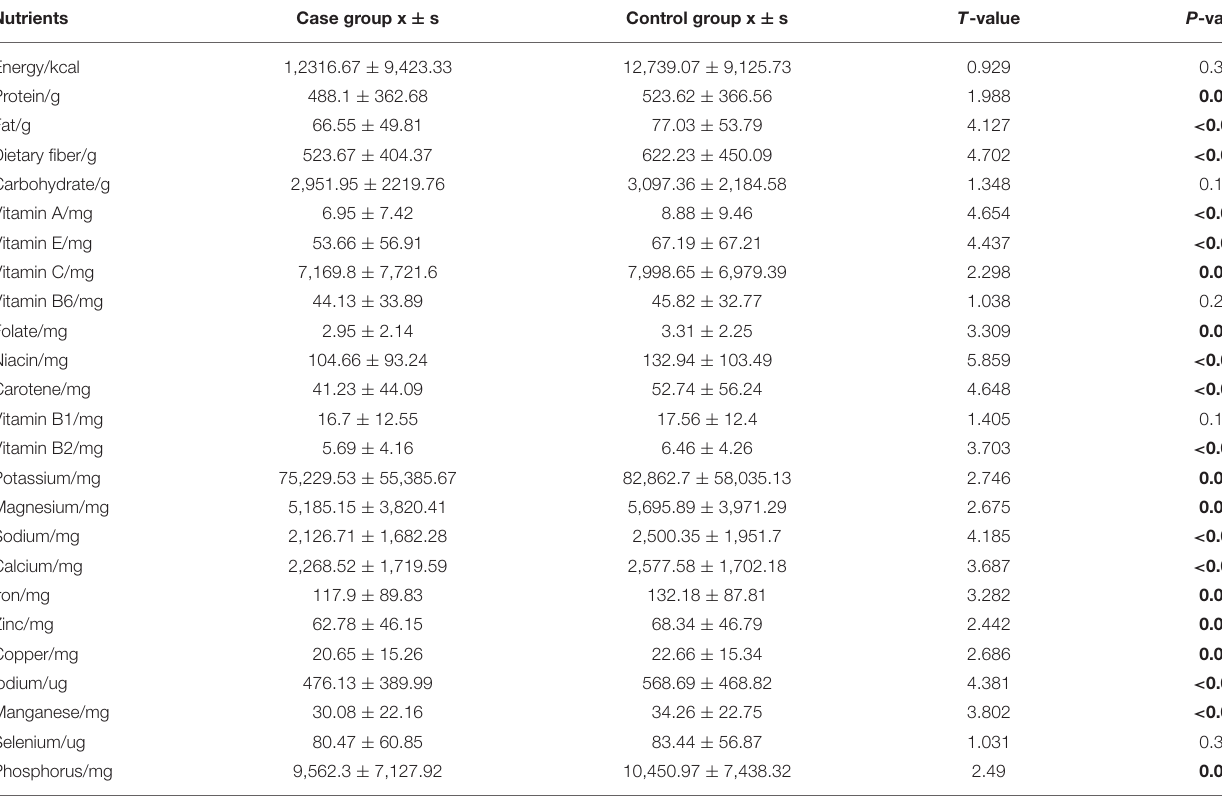
TABLE 6 | Comparison of nutrient intake between case group and control group.